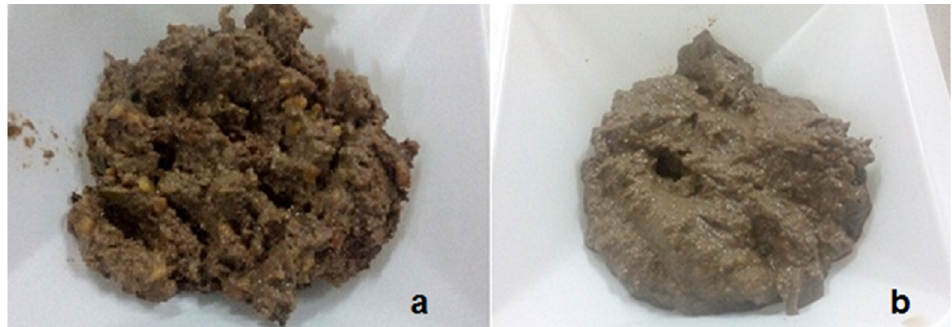
Figure 2. Olive alperujo: ( a ) without grinding and ( b ) with grinding.